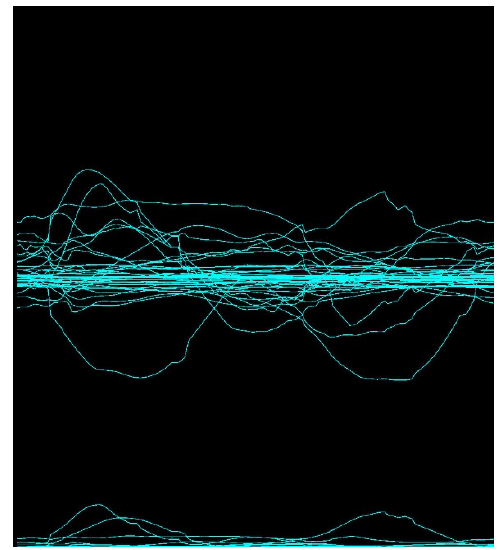
Figure 2. Reference graph.